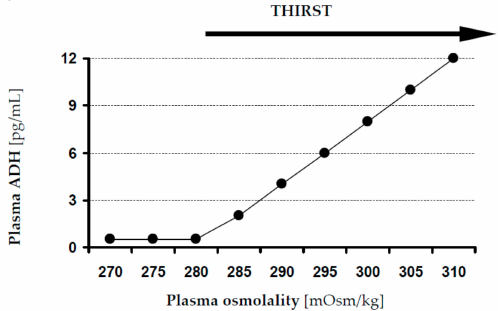
Figure 6. ADH release and thirst [56]. ADH: Antidiuretic hormone. Hypotonic fluids represent the best treatment option for hypertonic